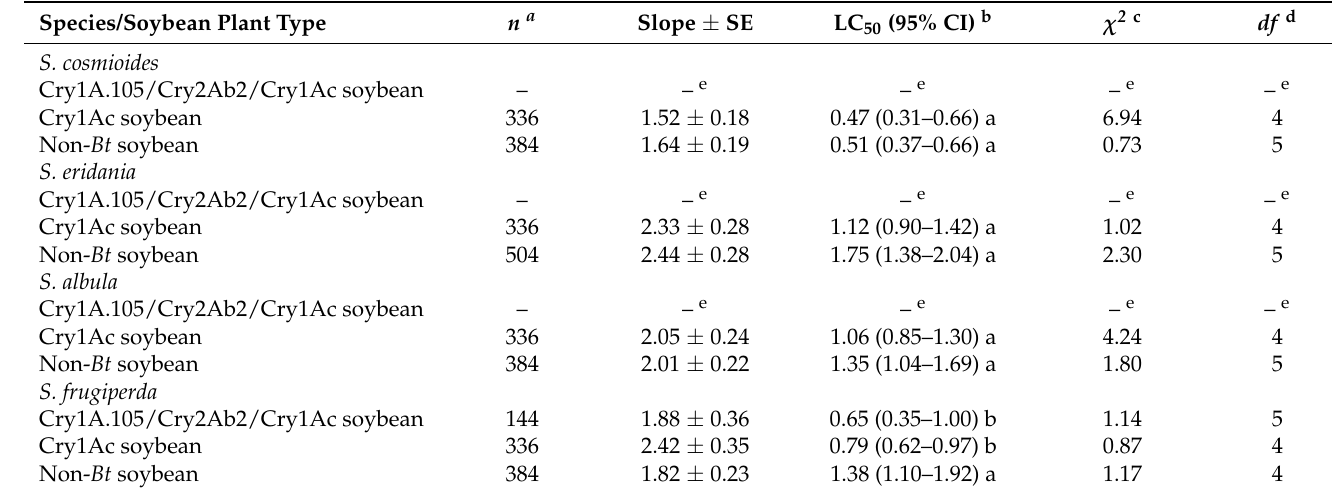
Table 4. Concentration–mortality response to thiodicarb by Spodoptera species developing on Bt and non- Bt soybean in laboratory bioassays.